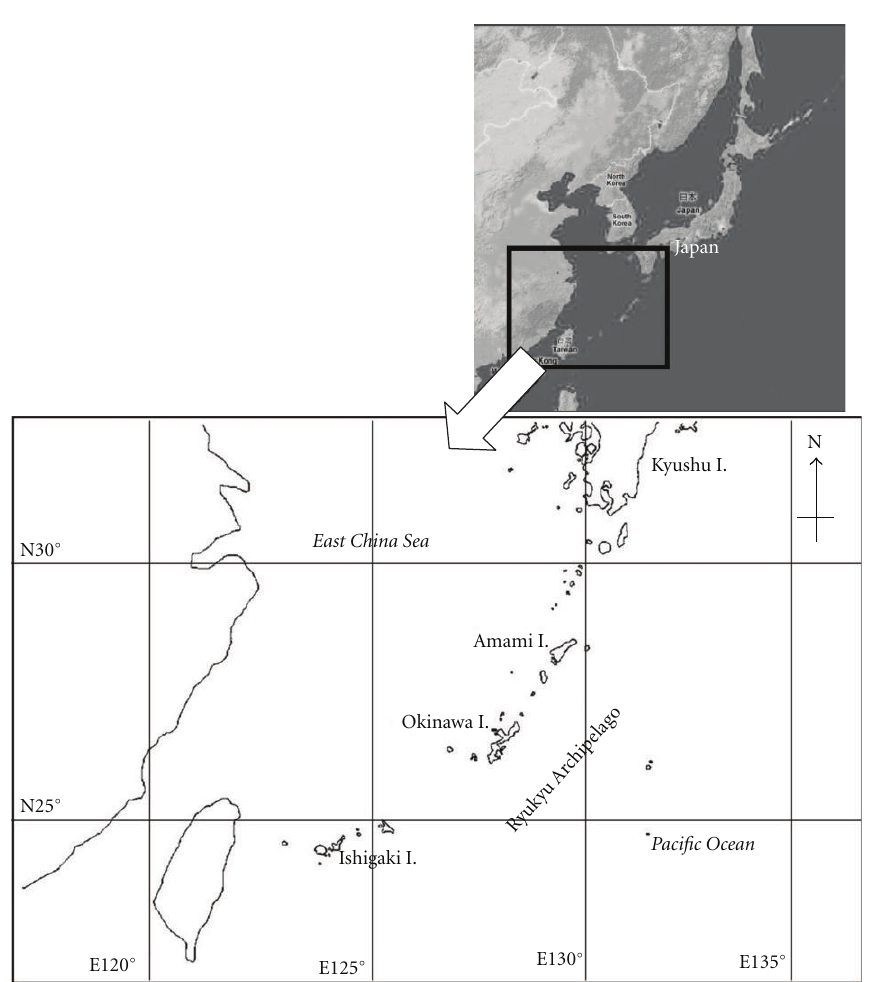
Figure 1: Map of precious coral sampling areas in southern Japan.